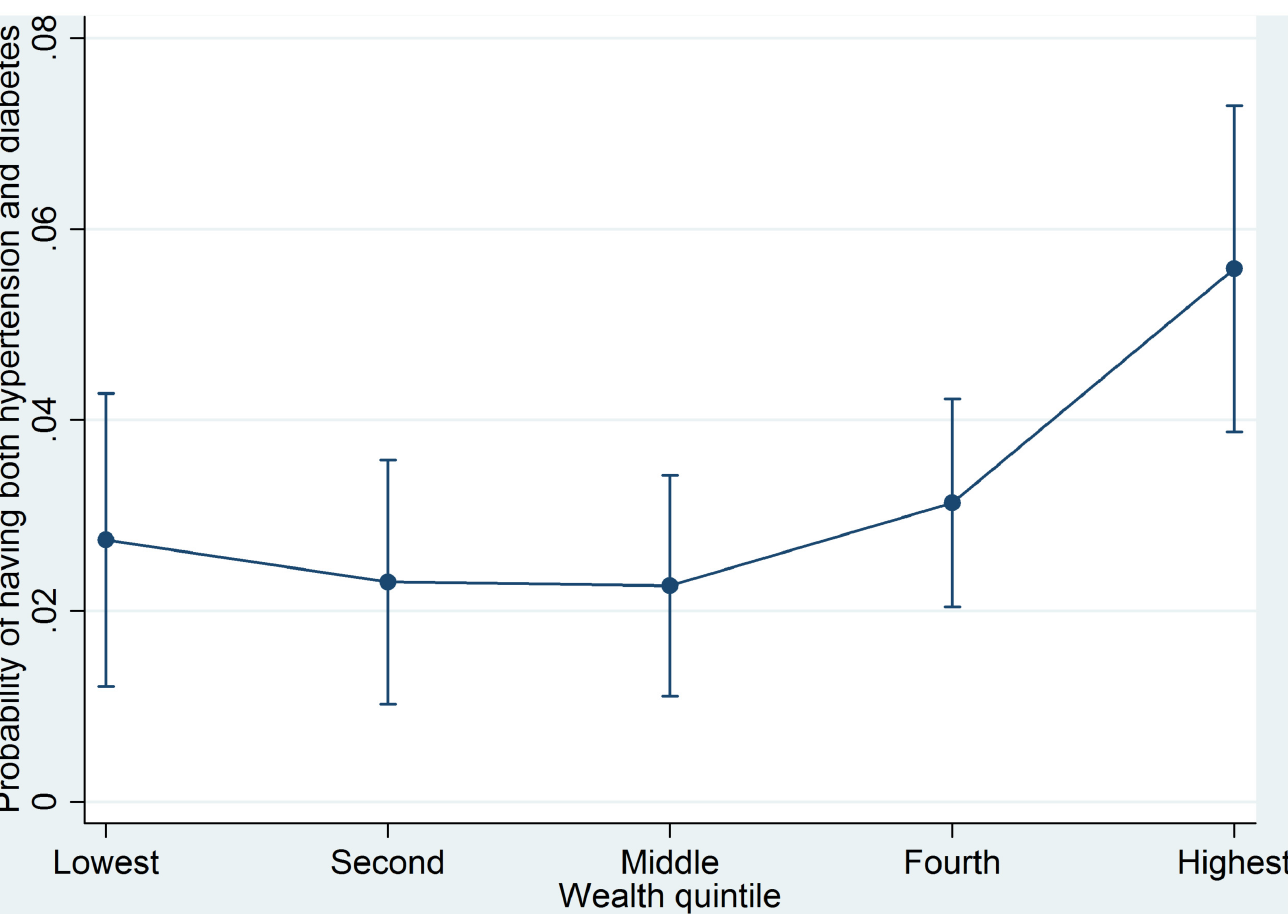
Fig 3. Predicted probabilities of having both hypertension and diabetes by wealth